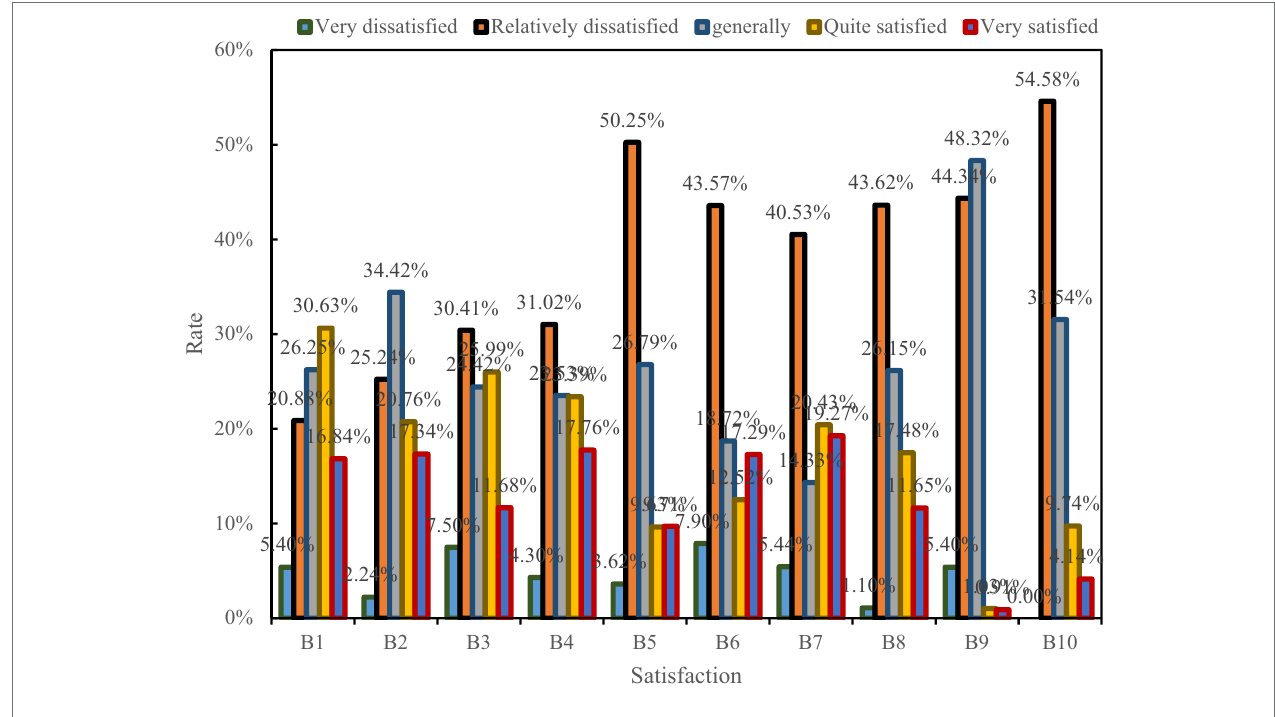
FIGURE 8 | Teaching security psychology management student satisfaction situation.